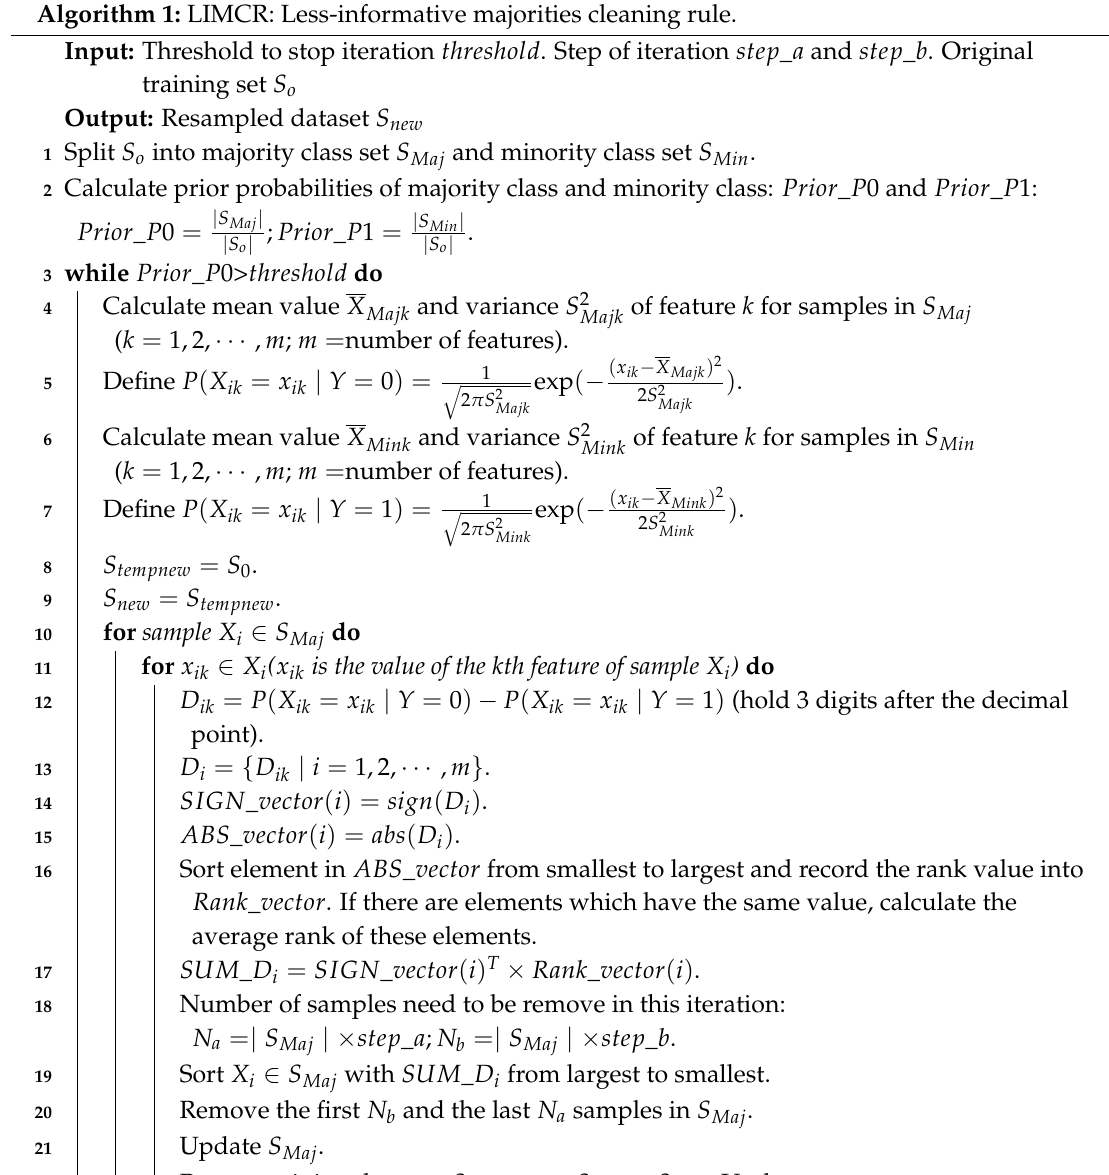
Algorithm 1: LIMCR: Less-informative majorities cleaning